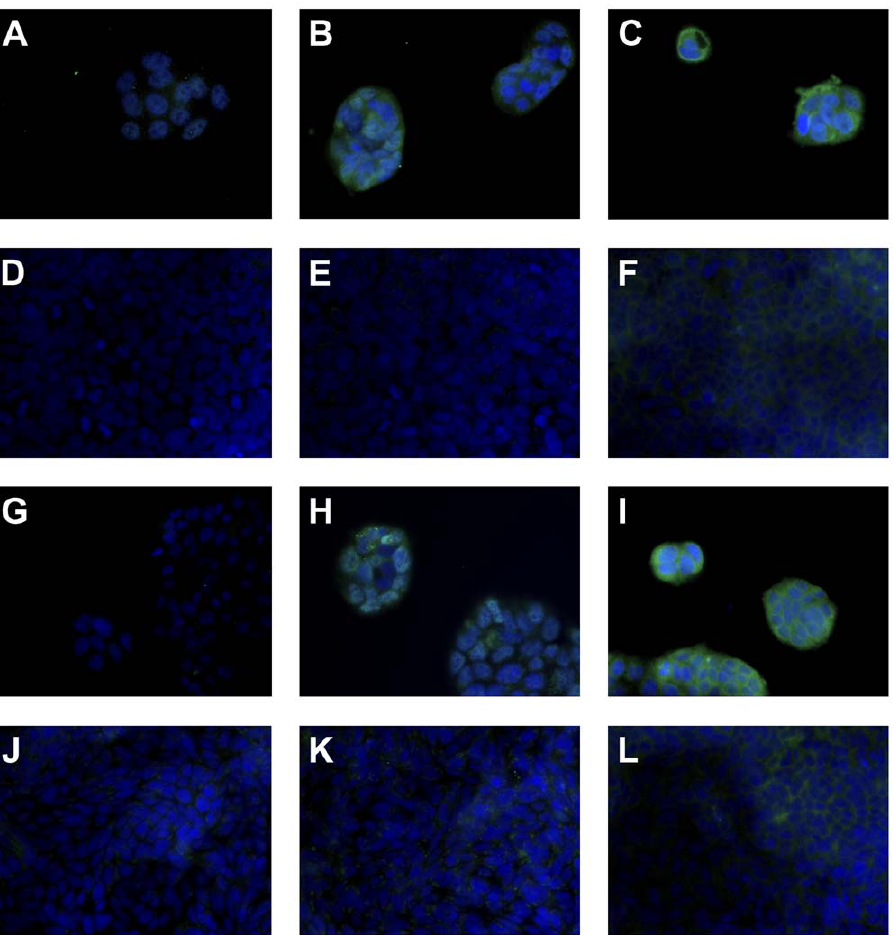
Figure 7. Abundant Fc e RI c -chain expression and IgE binding in subconfluent human intestinal tumor cell lines. Immunofluorescence staining of (A, D, G, J) Fc e RI b - and (B, E, H, K) Fc e RI c -chain are performed in (A–C) subconfluent and (D–F) confluent Caco2/TC7 and in (G–I) subconfluent and (J–L) confluent HCT-8. (C, F, I, L) According to the expression pattern of Fc e RI in the subconfluent cells, IgE binding is observed exclusively in subconfluent, non-mature intestinal cells. The blue fluorescence DAPI staining indicates the nuclei. Original magnification 6